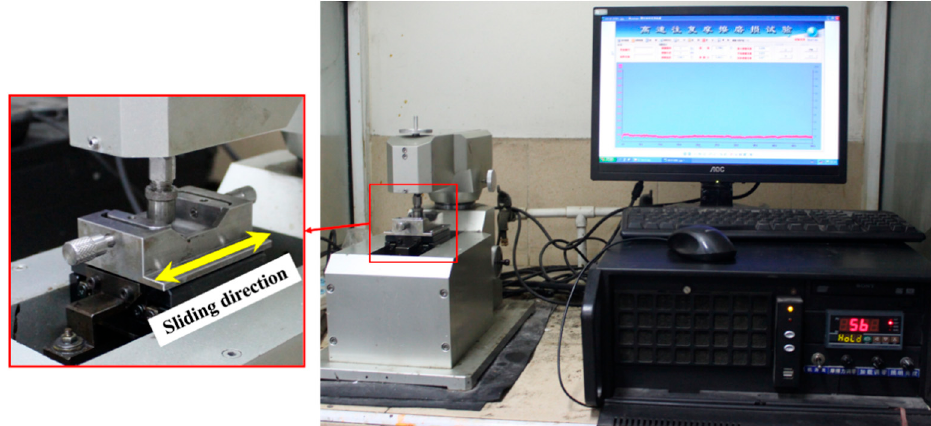
Figure 2. Digital photos of the reciprocating tribometer.